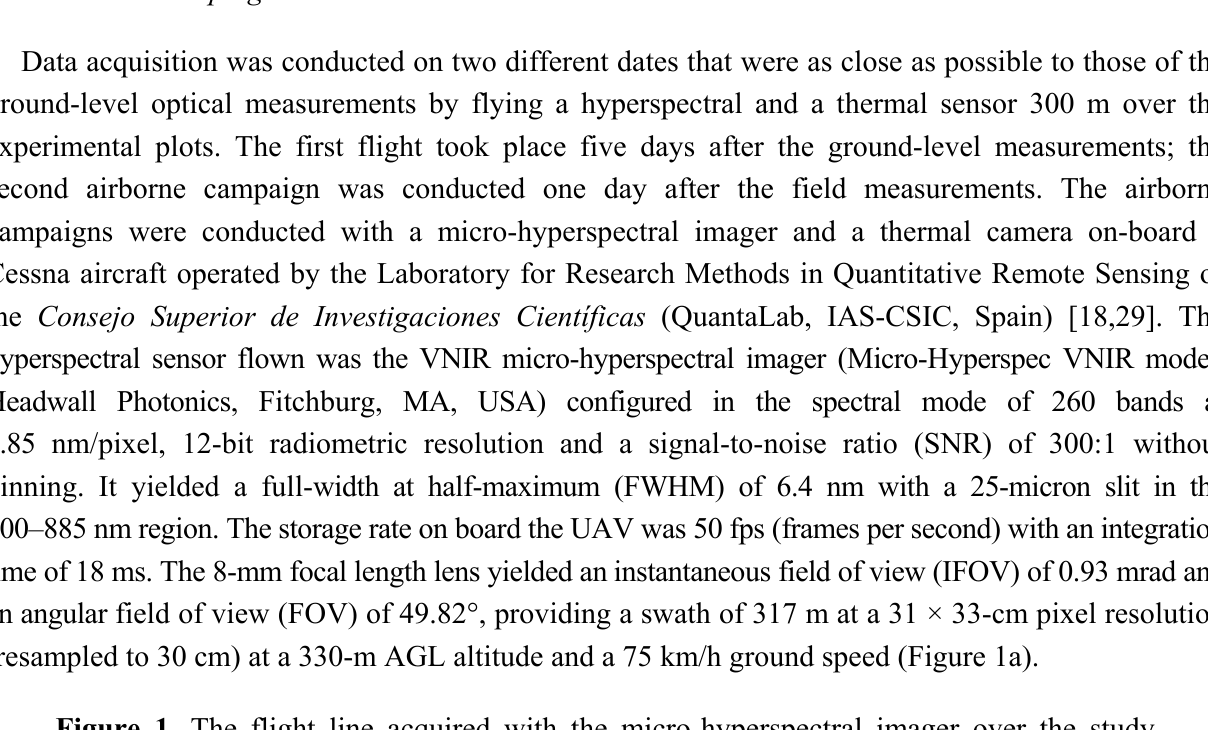
Figure 1. The flight line acquired with the micro-hyperspectral imager over the study site ( a ); showing the field ( b ) and the pixels extracted from each treatment for the analysis ( c